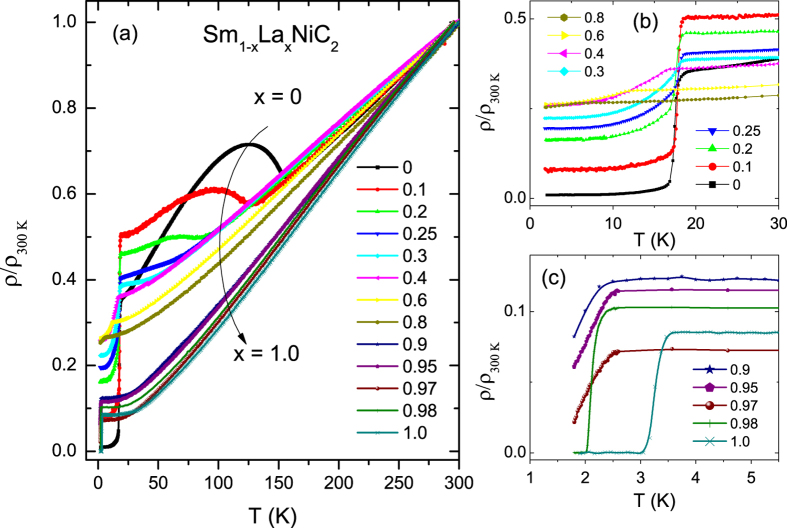
Electrical resistivity for La-doped SmNiC2.(a) Temperature dependence of the normalized electrical resistivity for Sm1−xLaxNiC2, 0 ≤ x ≤ 1. Low-temperature resistivity plots of the ferromagnetic (0 ≤ x ≤ 0.8) and superconducting transitions (0.9 ≤ x ≤ 1) are shown in (b,c), respectively.